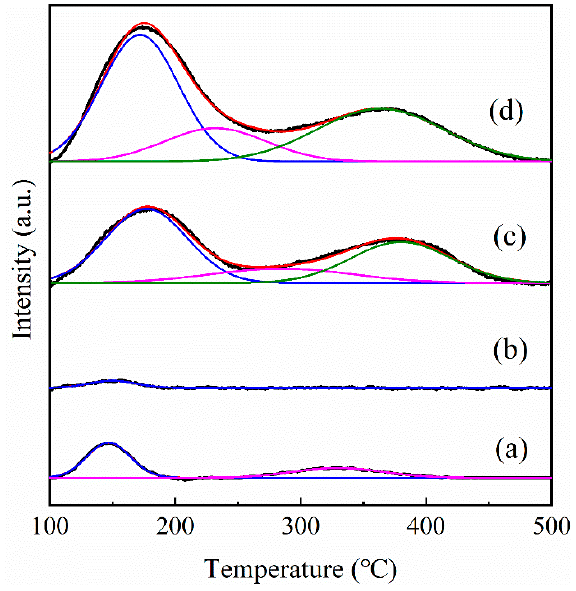
Figure 6. NH 3 -TPD profiles of ( a ) Pt/S-1, ( b ) Pt/hS-1, ( c ) Pt/hZSM-5, and ( d ) Pt/cZSM-5 catalysts.